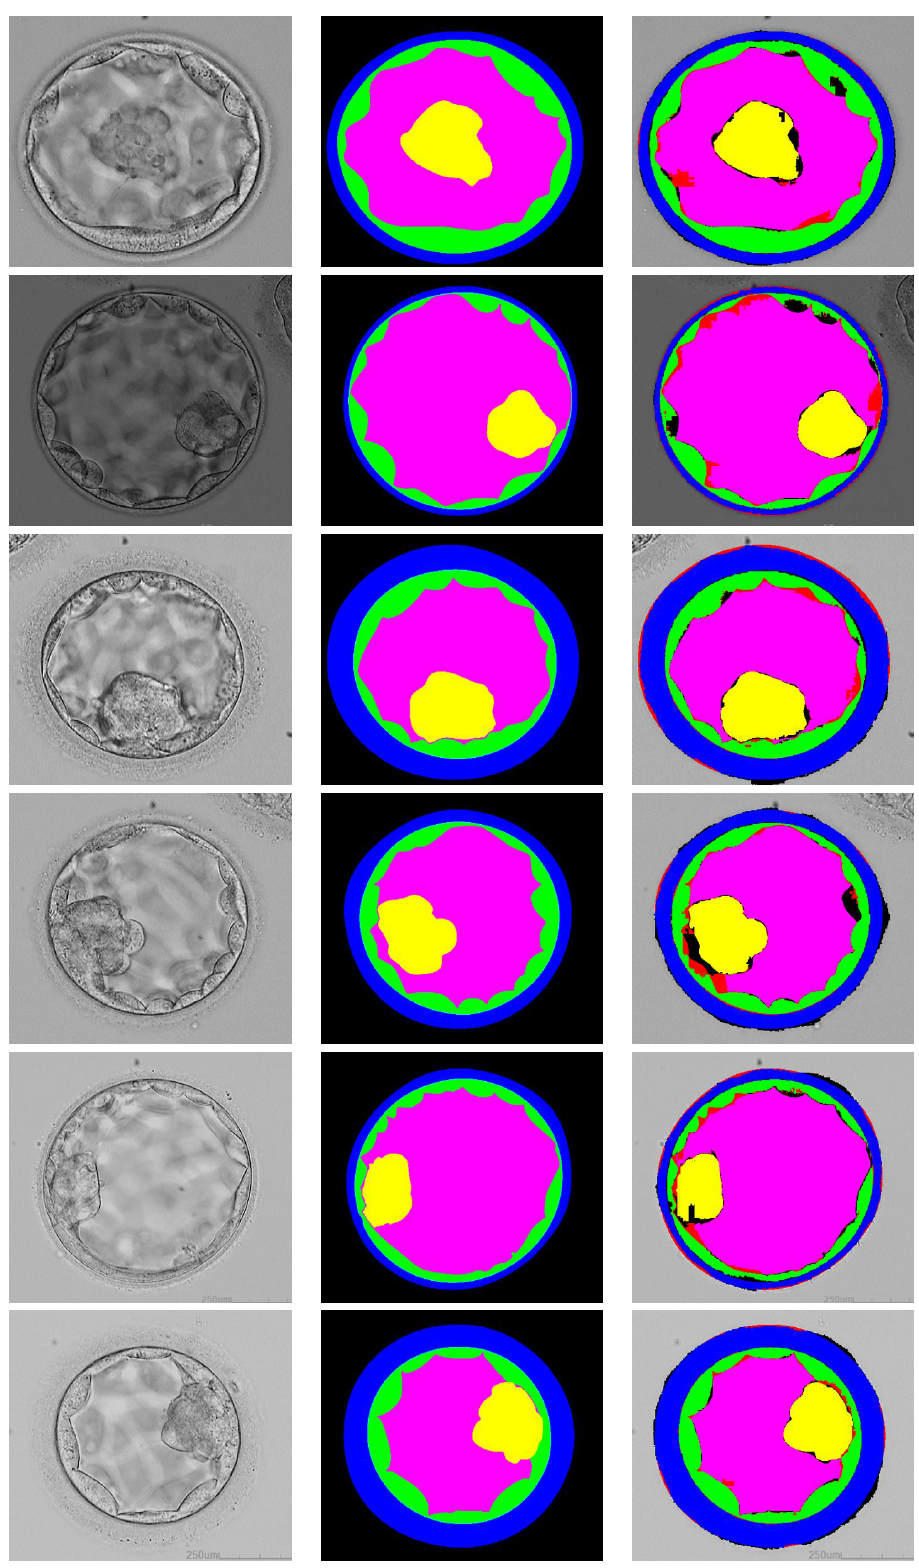
Figure 6. Visual results of embryo components combined segmentation using ECS-Net. From left-to- right: input images, expert label mask, segmentation by proposed